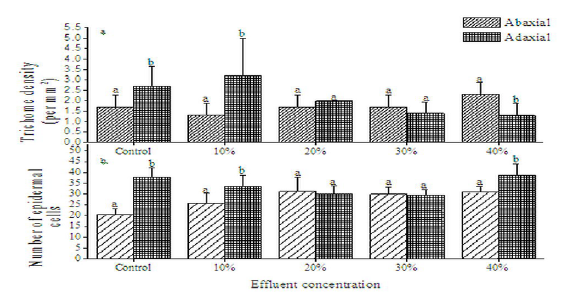
Tab. 2. Effects of pharmaceutical effluents on stomatal features of A.